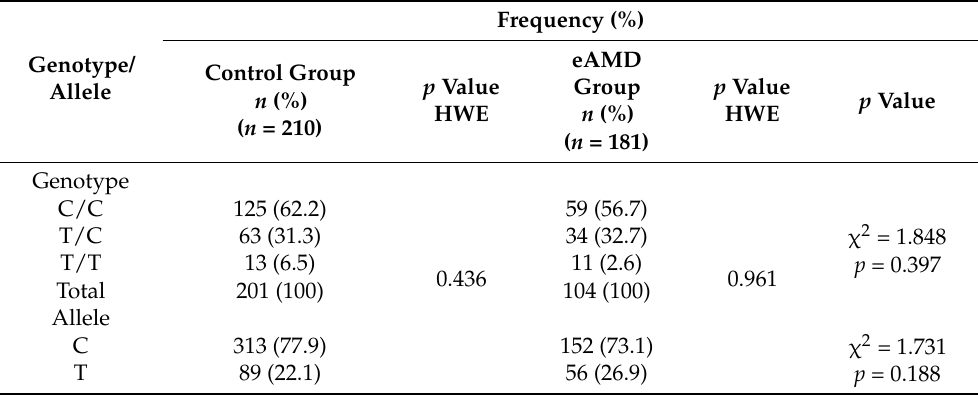
Table 3. Frequency of the ABCA1 rs1883025 genotypes in the eAMD and control groups.